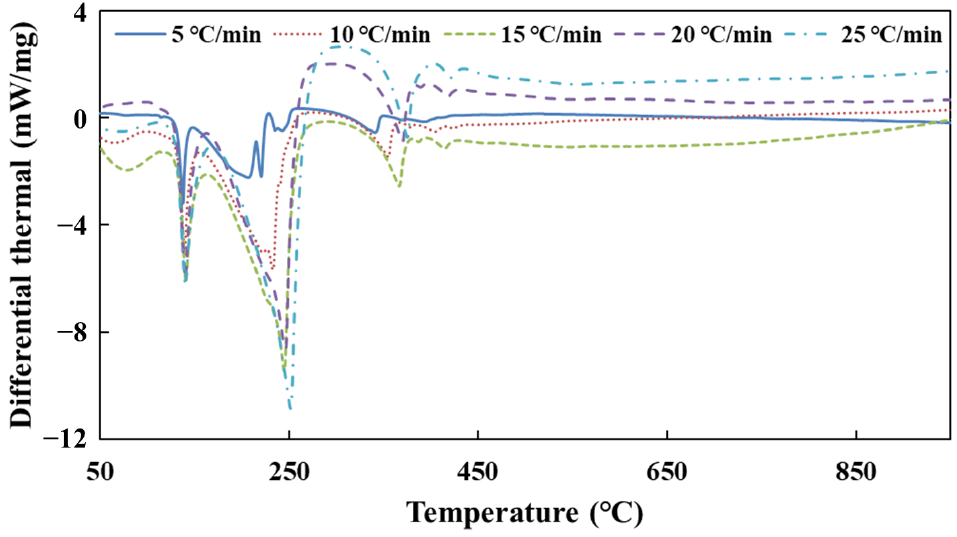
Figure 3. The DSC curves of urea pyrolysis at different heating rates. According to the DSC curves of urea pyrolysis, the peak temperature date T p is obtained at different heating rates. Table 4 shows the result of the activation energy of urea decomposition by substituting these data into Equation (32). Table 4. The activation energy E K of urea decomposition (Unit: